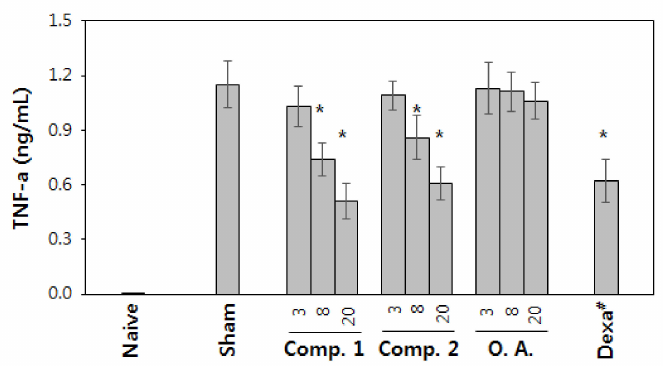
Figure 6. Inhibition of the activation of macrophage by orally administered compounds in vivo. After 4 days treatment with 20 mg / kg compounds 1 (Comp. 1 ) and 2 (Comp. 2 ) and oleanolic acid ( O.A. ), respectively, LPS was injected i.p., and the blood was drawn for the analysis of the concentration of TNF- α . The concentration of TNF- α was determined with ELISA (* p < 0.05, ANOVA). Dexamethasone ( Dexa # ) was used as the positive control. Sham means a negative control group that is injected with LPS to induce inflammation but not